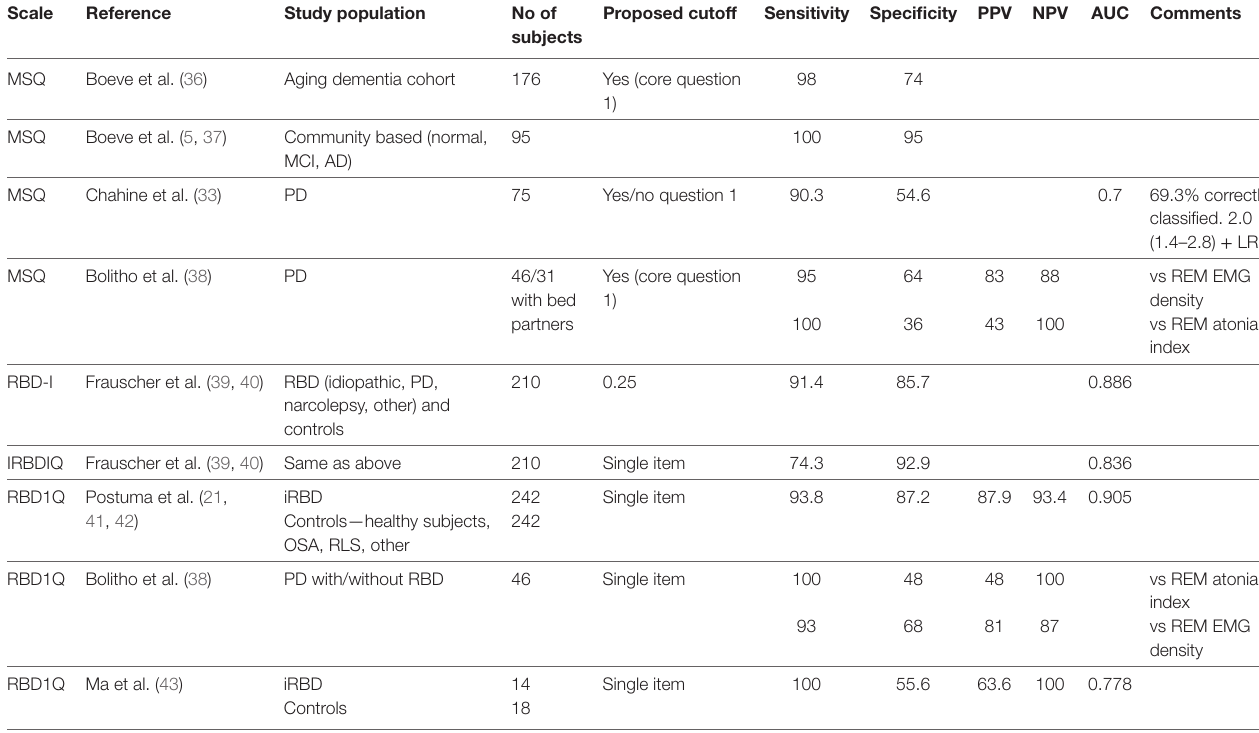
TABle 3 | Diagnostic accuracy of other RBD rating scales and screening items.